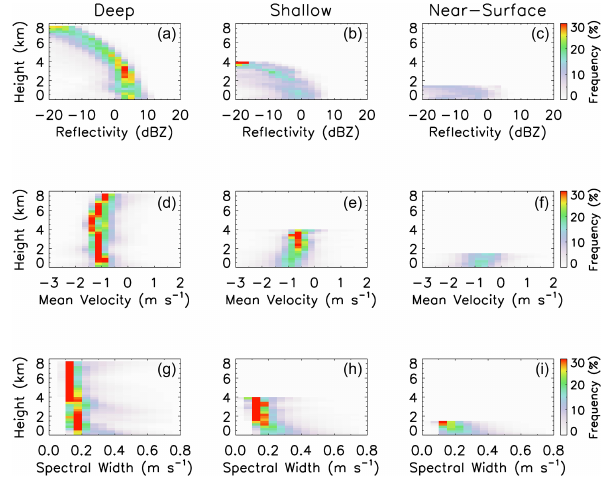
Figure 10. Contoured frequency by altitude diagrams (CFADs) for radar reflectivity (a, b, c) , mean Doppler velocity (d, e, f) , and Doppler spectral width (g, h, i) for deep (a, d, g) , shallow (b, e, h) , and near-surface (c, f, i) snow clouds. The frequency values are calculated in such a way that the sum of all frequency values at each altitude is 100%. All observed data from the 2017–2018 winter are